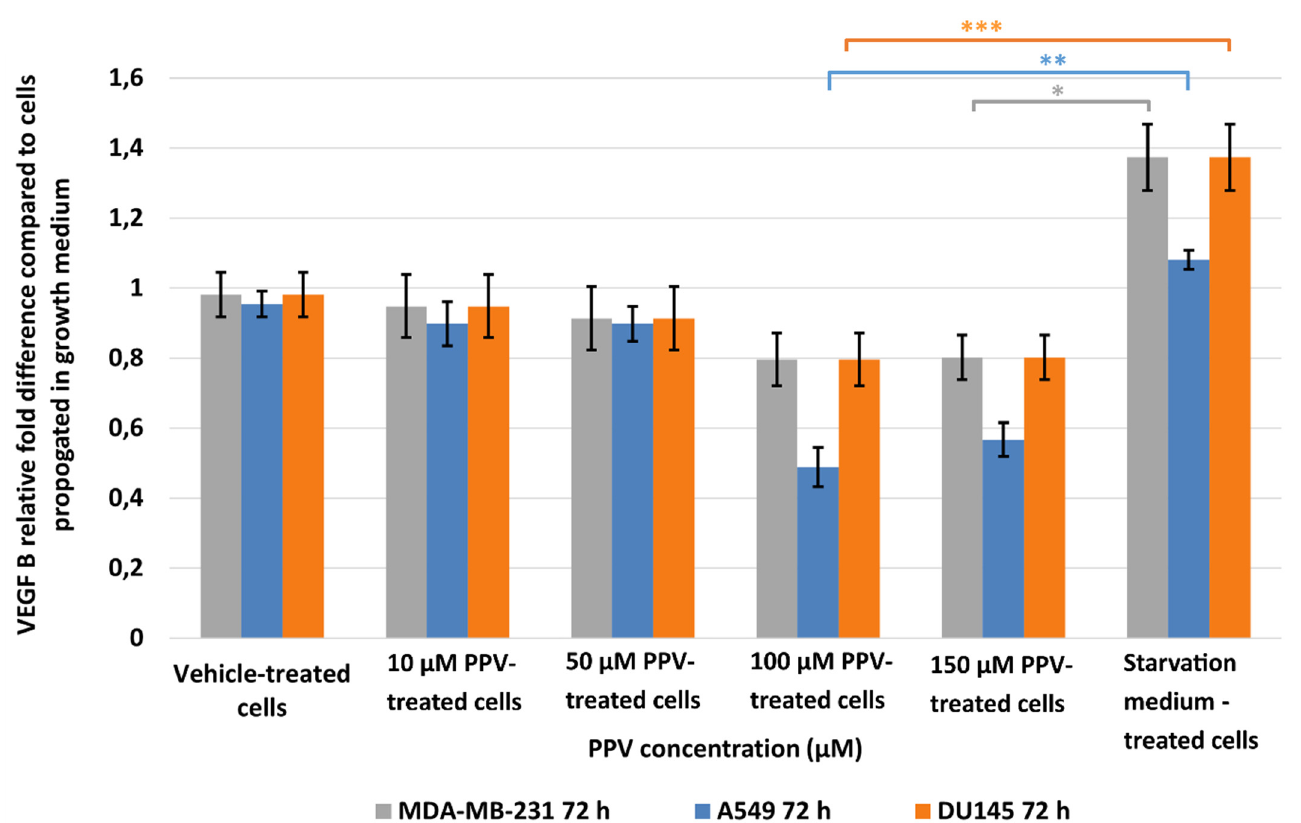
Figure 5. Spectrophotometry results of VEGF B ELISA demonstrating the effects of PPV (10–300 µ M) on proliferation on MDA-MB-231 cells compared to A549- and DU145 cell lines at 72 h. The average of three independent experiments is represented by the graph with error bars indicating standard deviation. The statistical significance of MDA-MB-231 cells is indicated with an asterisk (*), the statistical significance of A549 cells is indicated with two asterisks (**), and the statistical significance of DU145 cells is indicated with three asterisks (***). Statistical significance is represented by an * when using the student t -test with a p value of 0.05 compared to cells propagated in complete growth medium.